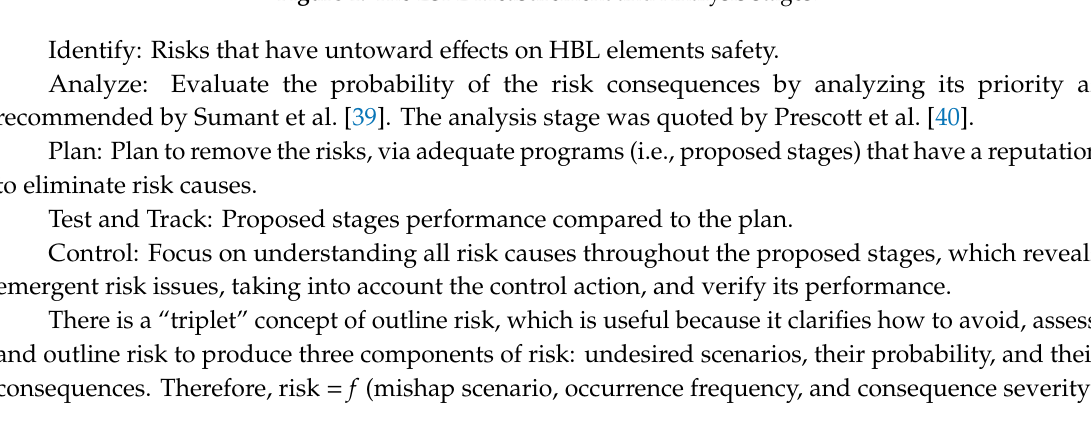
Table 3. Lean Safety Performance Level (LSPL) and their implementation tools’